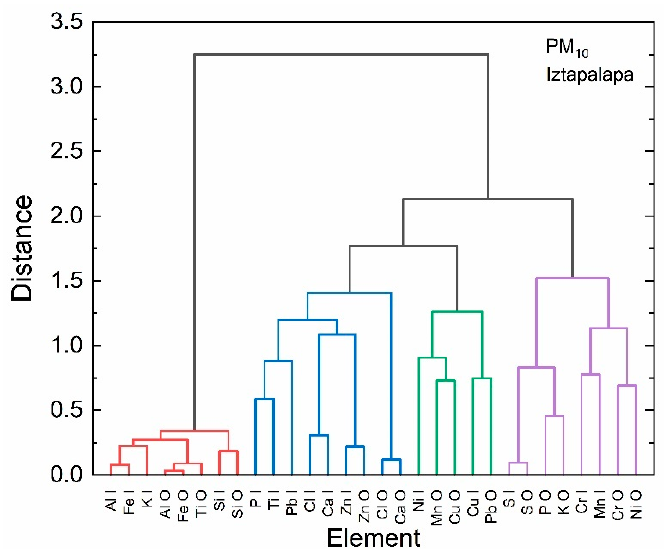
Figure 4. Dendrogram for indoor (I) and outdoor (O) elemental concentrations measured in Iztapa- lapa.